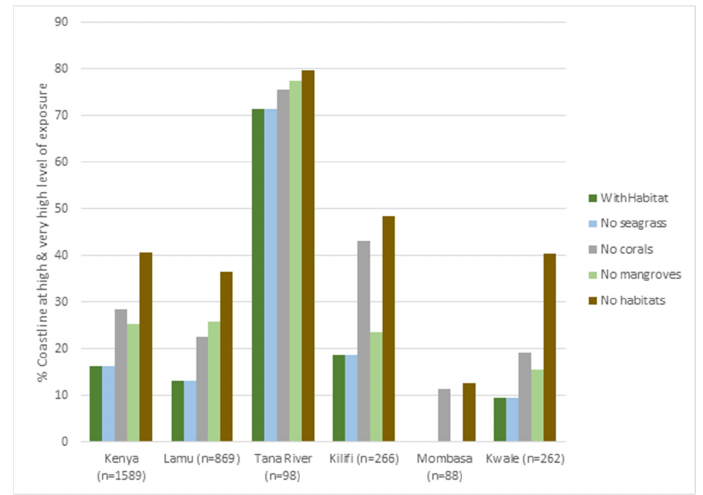
Figure 4. Different habitat contributions in reducing exposure levels along the Kenyan Coast.